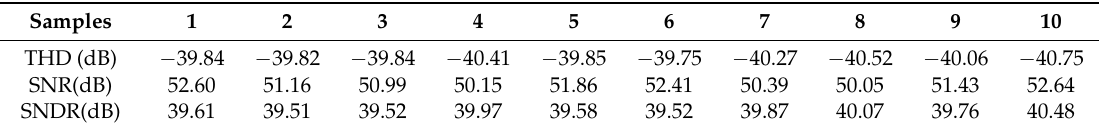
Figure 14. Frequency response of simulated 10 Monte Carlo samples with random noises and a 210 Hz sine wave at node V SS of Figure 12 for the proposed light detector, with R SS = 1 k Ω . Table 3. Simulated THDs, SNRs, and SNDRs of the 10 Monte Carlo samples with random noises at node V SS of Figure 14 for the proposed light detector.